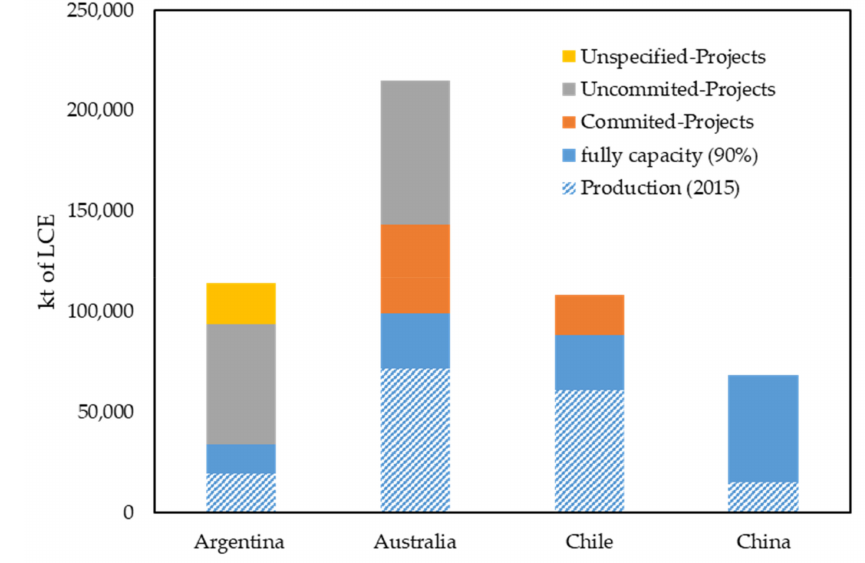
Figure 4. Unspecified project, uncommitted projects, committed projects, and the assumed full capacity of 90% for the main countries expressed as the lithium carbonate equivalent